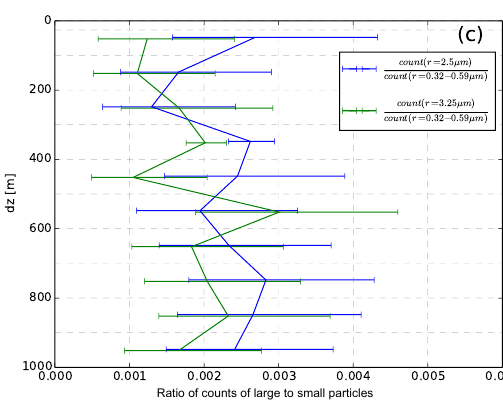
Figure 9. Ratios between counts in different size ranges measured by CAS-DPOL during aircraft ascent and descent (a) between 18:09 and 20:10UTC on 22 June 2013, (b) between 15:14 and 16:42UTC on 10 July 2013, and (c) between 12:45 and 13:50UTC on 11 July 2013. The aircraft locations are illustrated in the Supplement S3. The vertical axis shows the distance from the SAL top. The data were grouped in 100m wide vertical bins. The error bars are Poisson 95% confidence